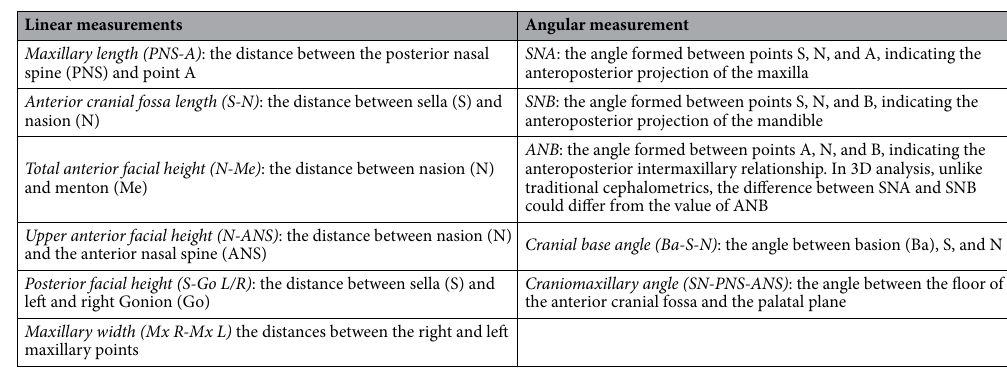
Table 1. Definition of the cephalometric measurements used in the present